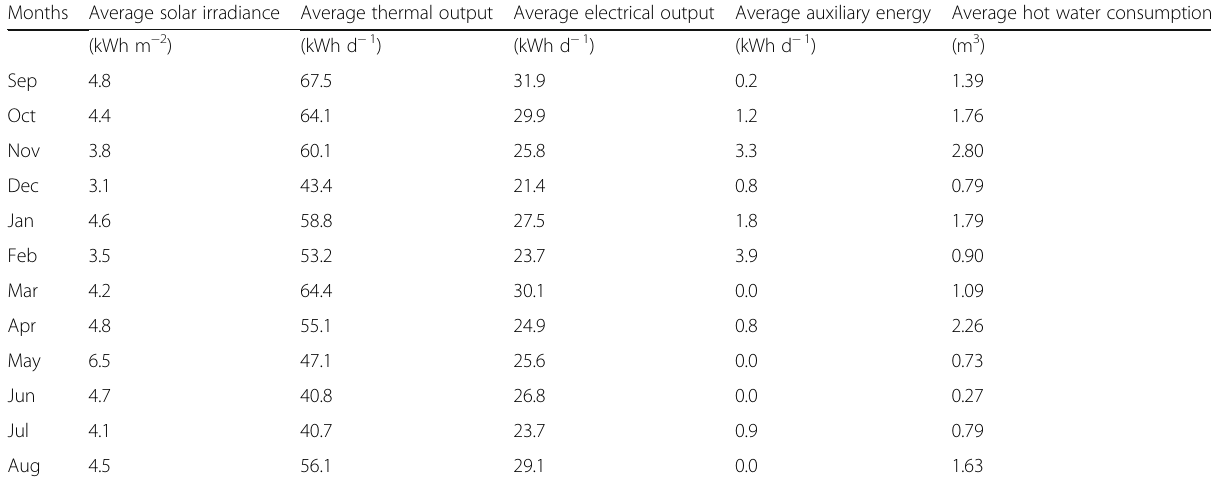
Table 4 Yearly electrical and thermal output of the system and auxiliary energy